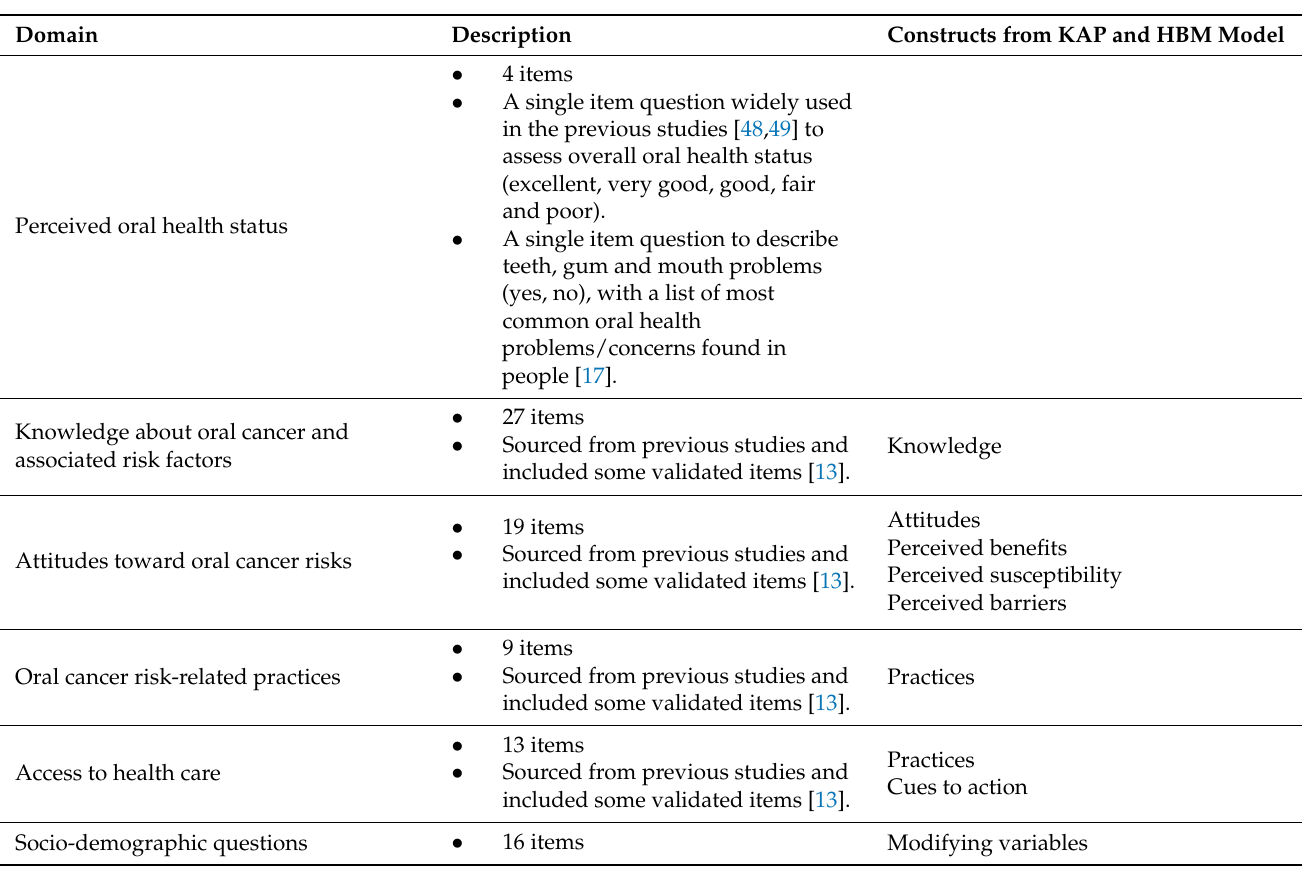
Table 1. Measures of